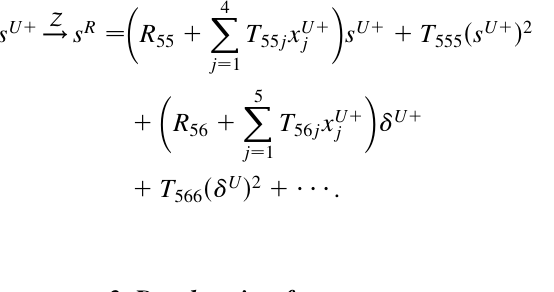
and T [for (a) (cid:3) 0 : 2 and 0. m; for (b) 0.2 and 56 566